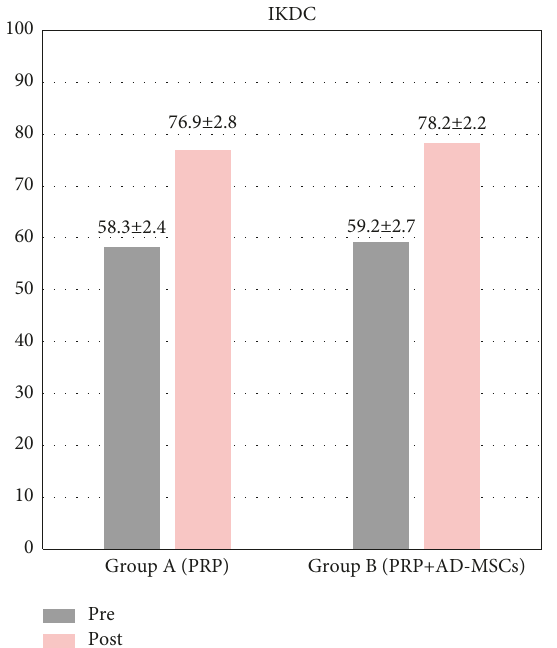
Figure 2: IKDC (International Knee Documentation Committee) score: pretreatment and at 12-months